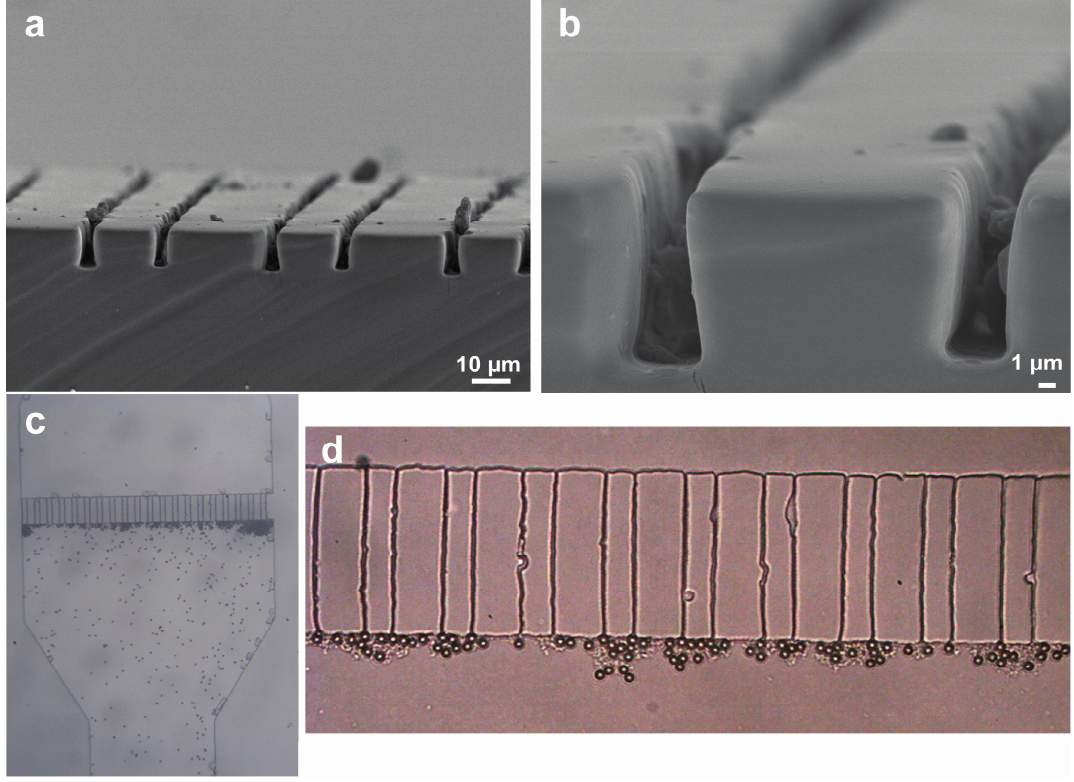
Figure 6. PDMS microfluidic devices that incorporate micropillar-based filters,